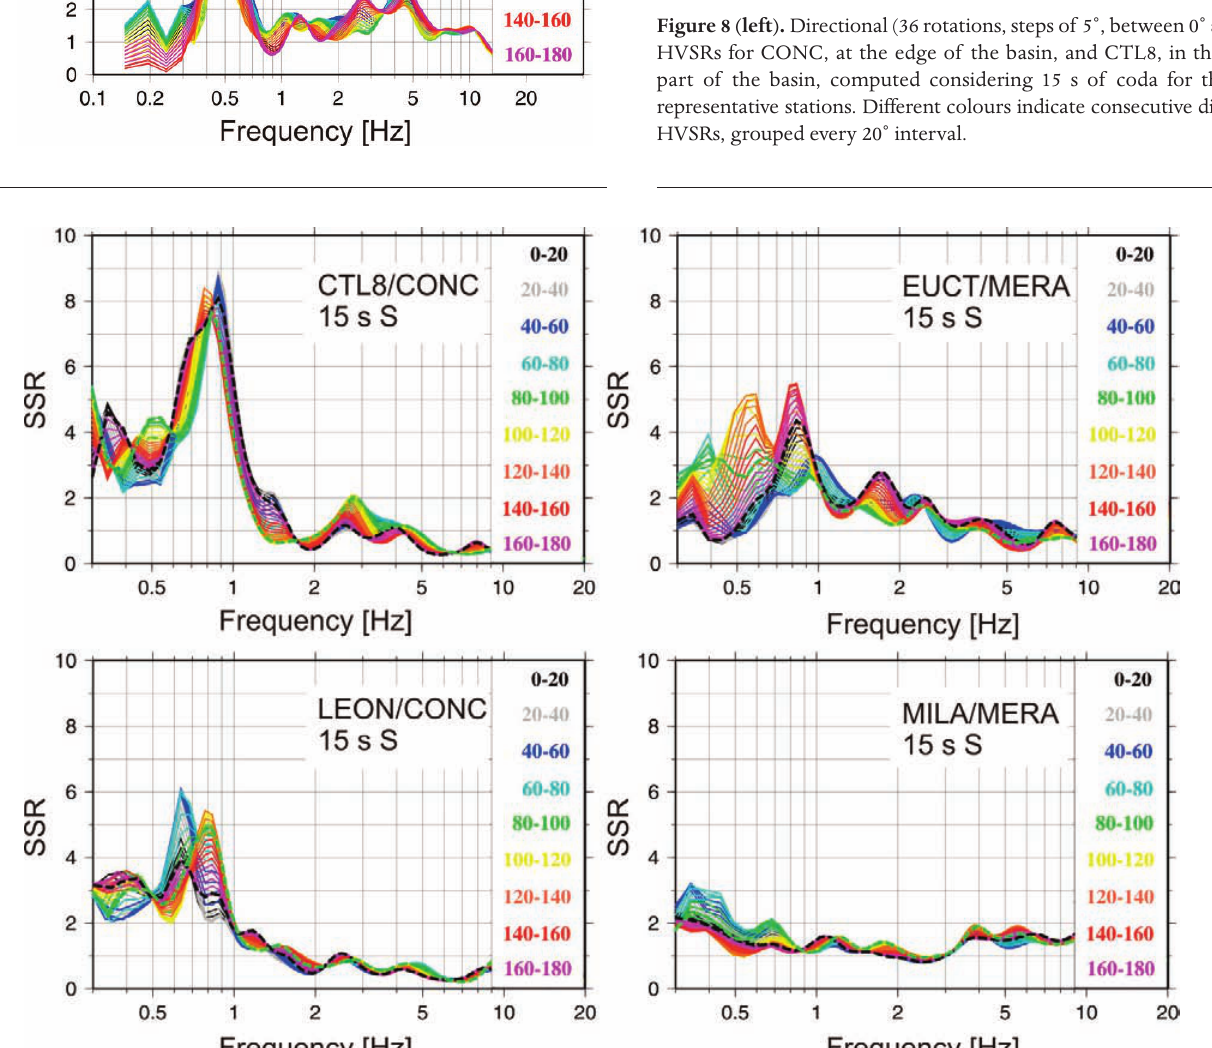
Figure 8 (left). Directional (36 rotations, steps of 5˚, between 0˚ and 175˚) HVSRs for CONC, at the edge of the basin, and CTL8, in the central part of the basin, computed considering 15 s of coda for these two representative stations. Different colours indicate consecutive directional HVSRs, grouped every 20˚ interval.